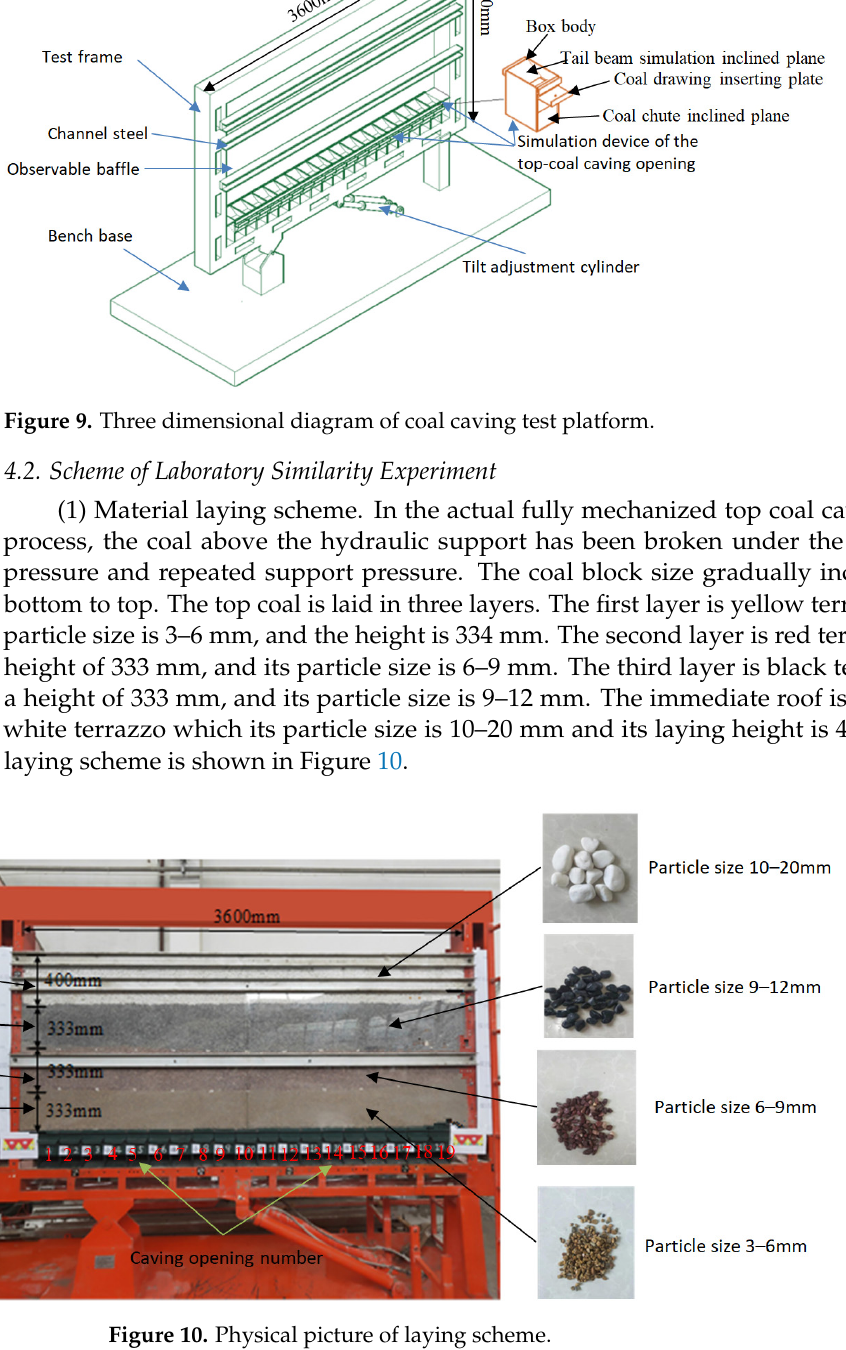
Table 5. The coal drawing sequence of similar simulation.